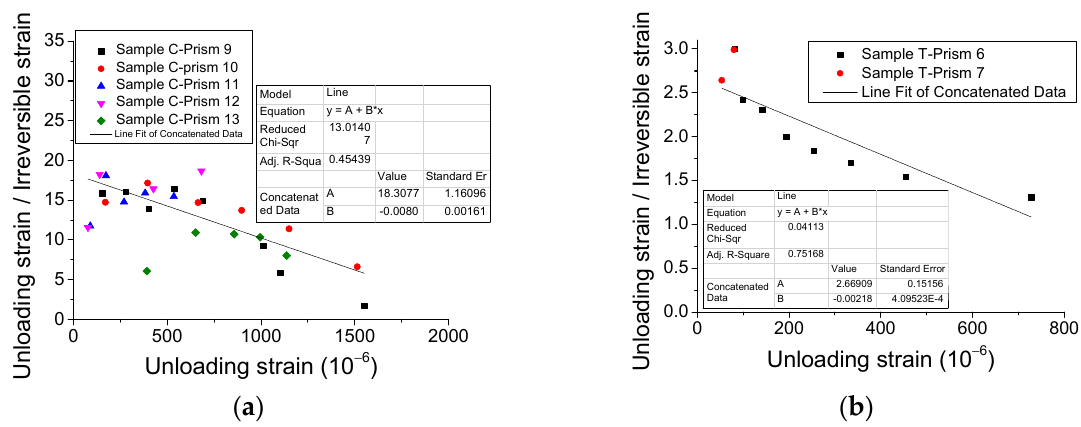
Figure 12. Relationship of unloading strain/irreversible strain–unloading strain. ( a ) Compressive case and ( b ) direct tensile case.